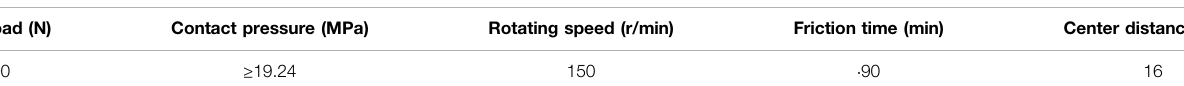
TABLE 3 | The parameters of friction and wear test.